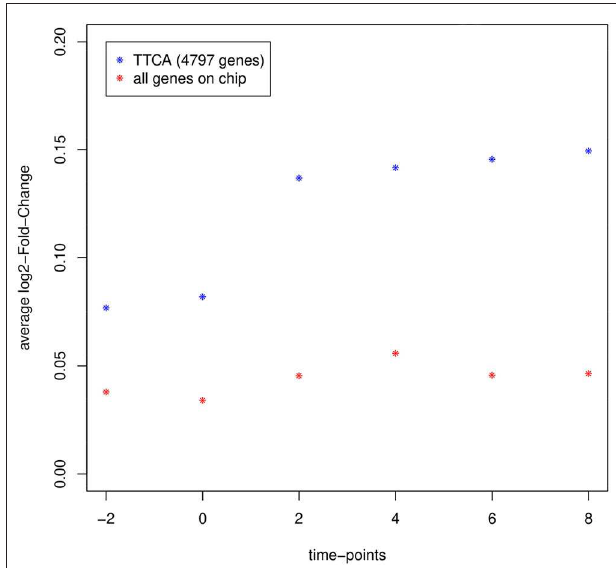
FIGURE 1 | Average log 2 -fold-change of gene expression intensity between epididymal and inguinal at each measured time point of all genes on the chip considered for analysis (red; N = 62,349) compared to genes reported as differentially expressed by TTCA (blue; N = 4,797). Gene expression intensities in both types of adipocytes diverge after the differentiation stimulus at day 0 and TTCA is able to select genes with highly different expression in the